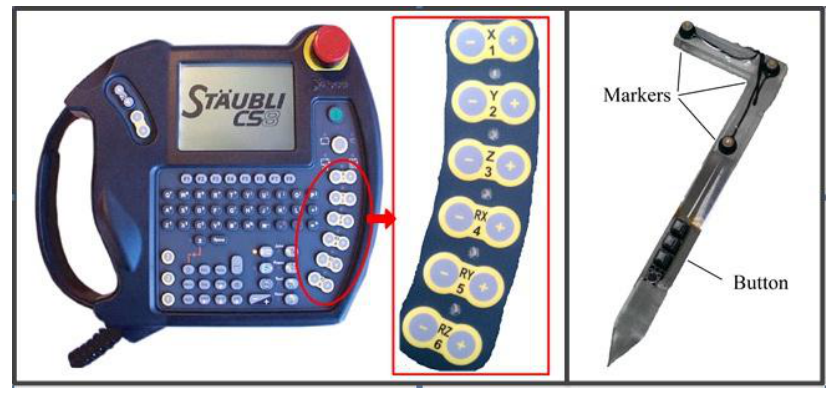
Figure 2. ( a ) The traditional teach pendant; ( b ) the proposed teach